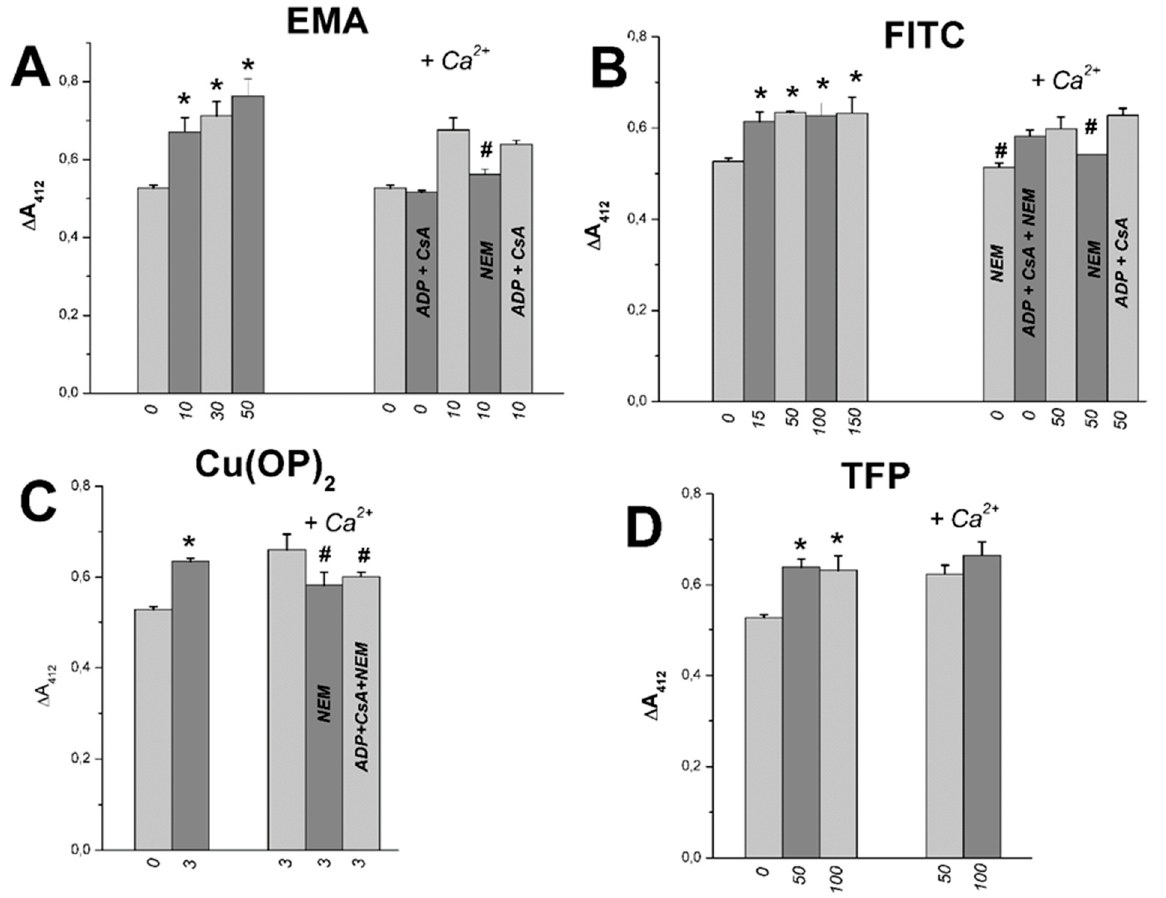
Figure 13. Effects of EMA, FITC, Cu(OP) 2 , TFP, and Ca 2+ on the SH-group content in succinate-energized rat liver mitochondria in sucrose medium. Additions, experimental procedures and designations are as in Figure 12. The medium is the same as in Figure 12; however, 75 mM TlNO 3 was replaced by 150 mM sucrose. Reagents (EMA ( A ), FITC ( B ), Cu(OP) 2 ( C ), TFP ( D )) were injected into the medium before mitochondria. Asterisks and hash signs indicate correspondingly statistical differences between appropriate values and the control (free of thiol reagents or Ca 2+ alone) which are statistically significant ( p < 0.05).